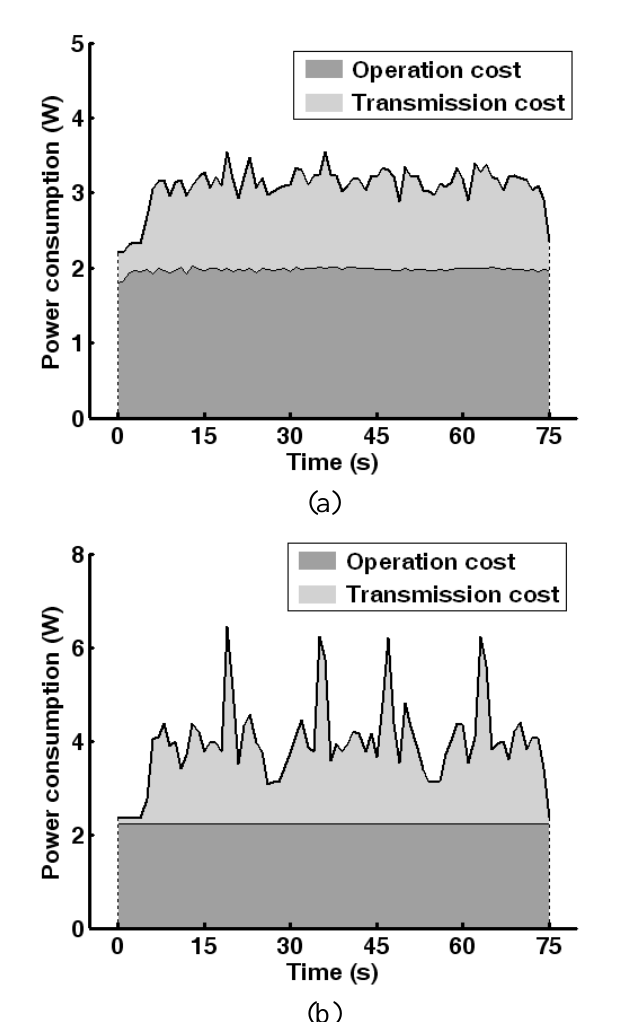
Figure 12. Power consumption curves of WSN including operation and transmission cost: (a) Energy-efficient organization; (b) General